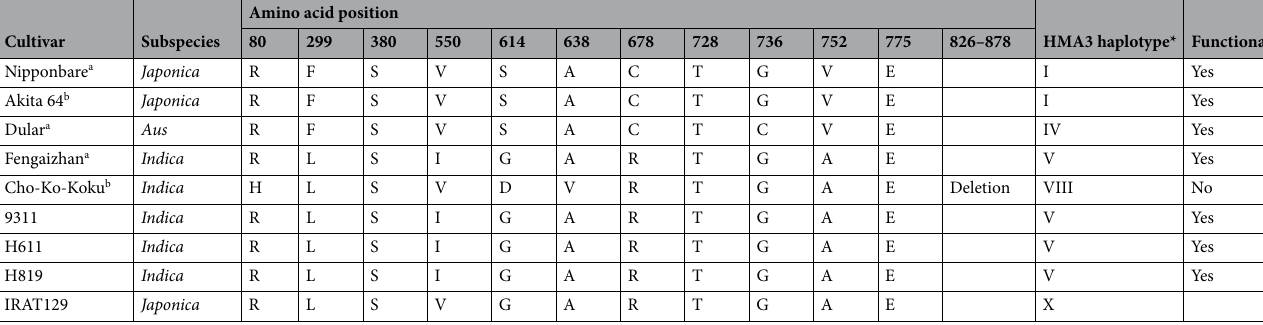
Table 6. OsHMA3 haplotypes of 9311, H611 and IRAT129. a The data was cited from Yan et al 24 . b The data was cited from Miyadate et al. 13 .